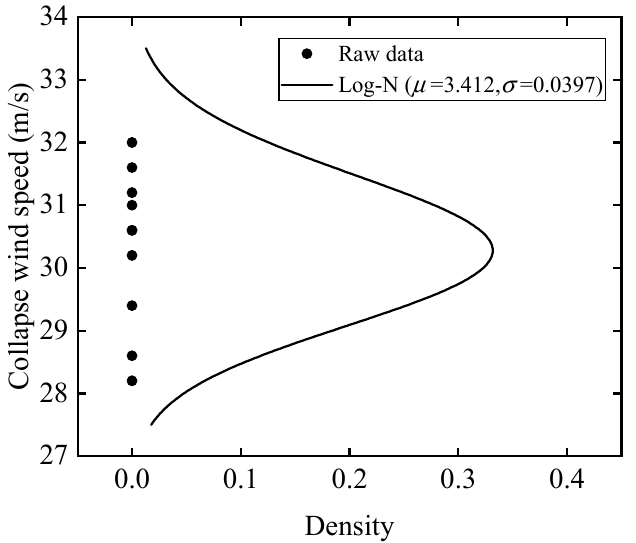
Figure 8. The log mean and log-standard deviation of the basic collapse wind speeds for the standard-value model were 3.412 and 0.0397, respectively.